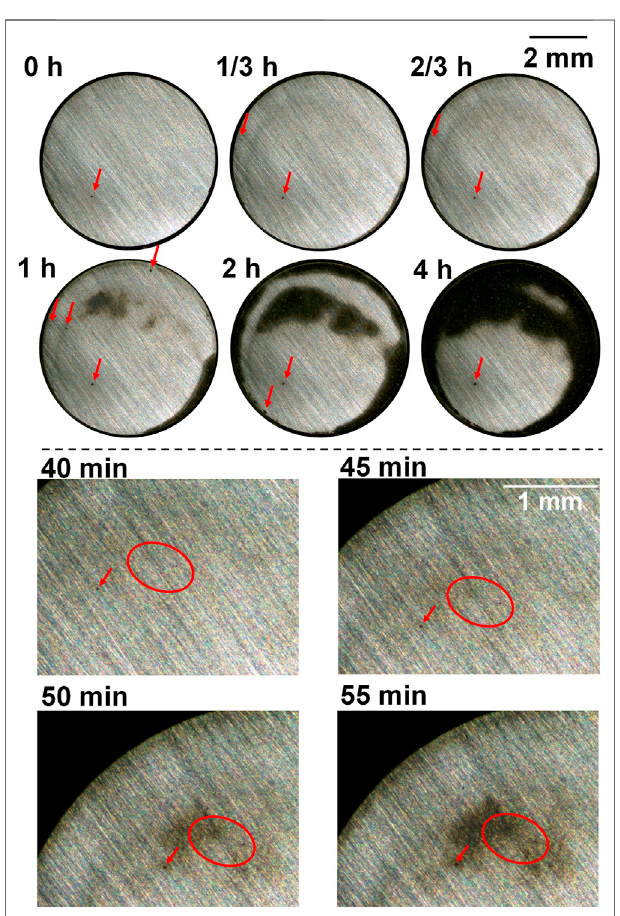
Frontiers in Materials |